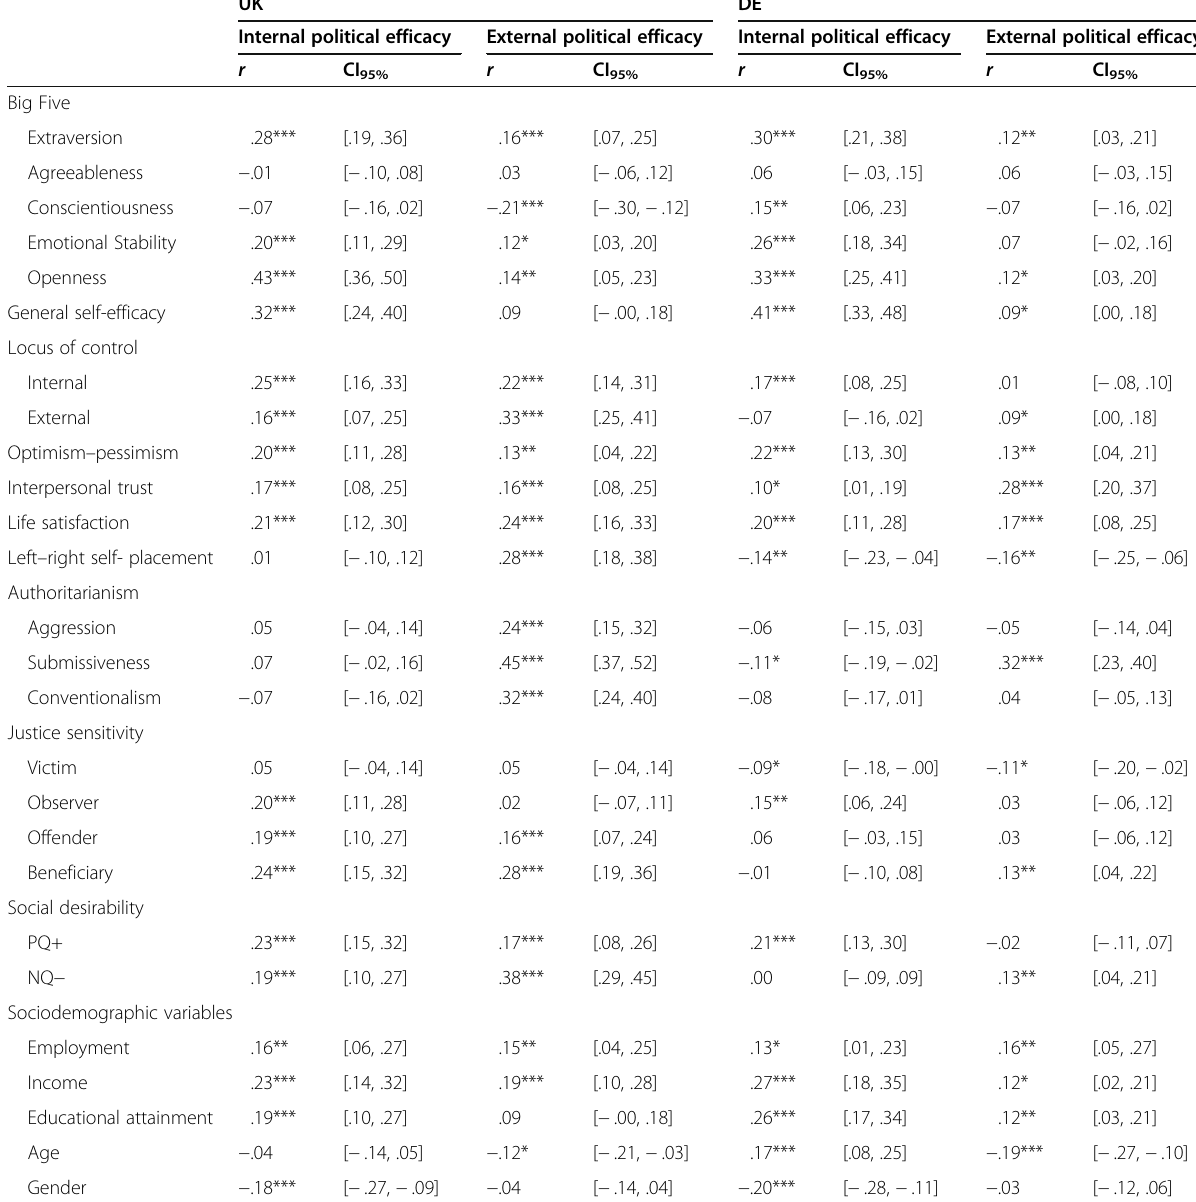
Table 4 Correlations of internal and external political efficacy with relevant variables in the UK and German samples